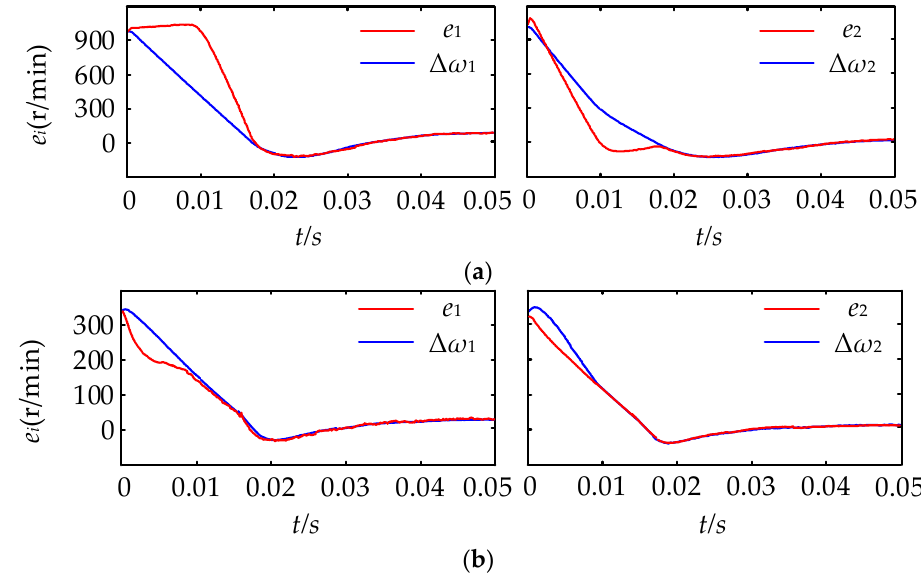
Figure 11. Input e 1 of the speed loop controller of the two structures: ( a ) e 1 in the traditional cross-coupling control structure; ( b ) e 1 in the fuzzy self-adjusting cross-coupling control structure.